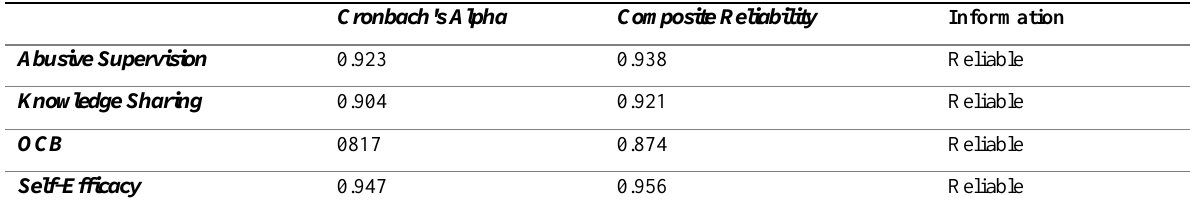
Table 4: Composite Reliability